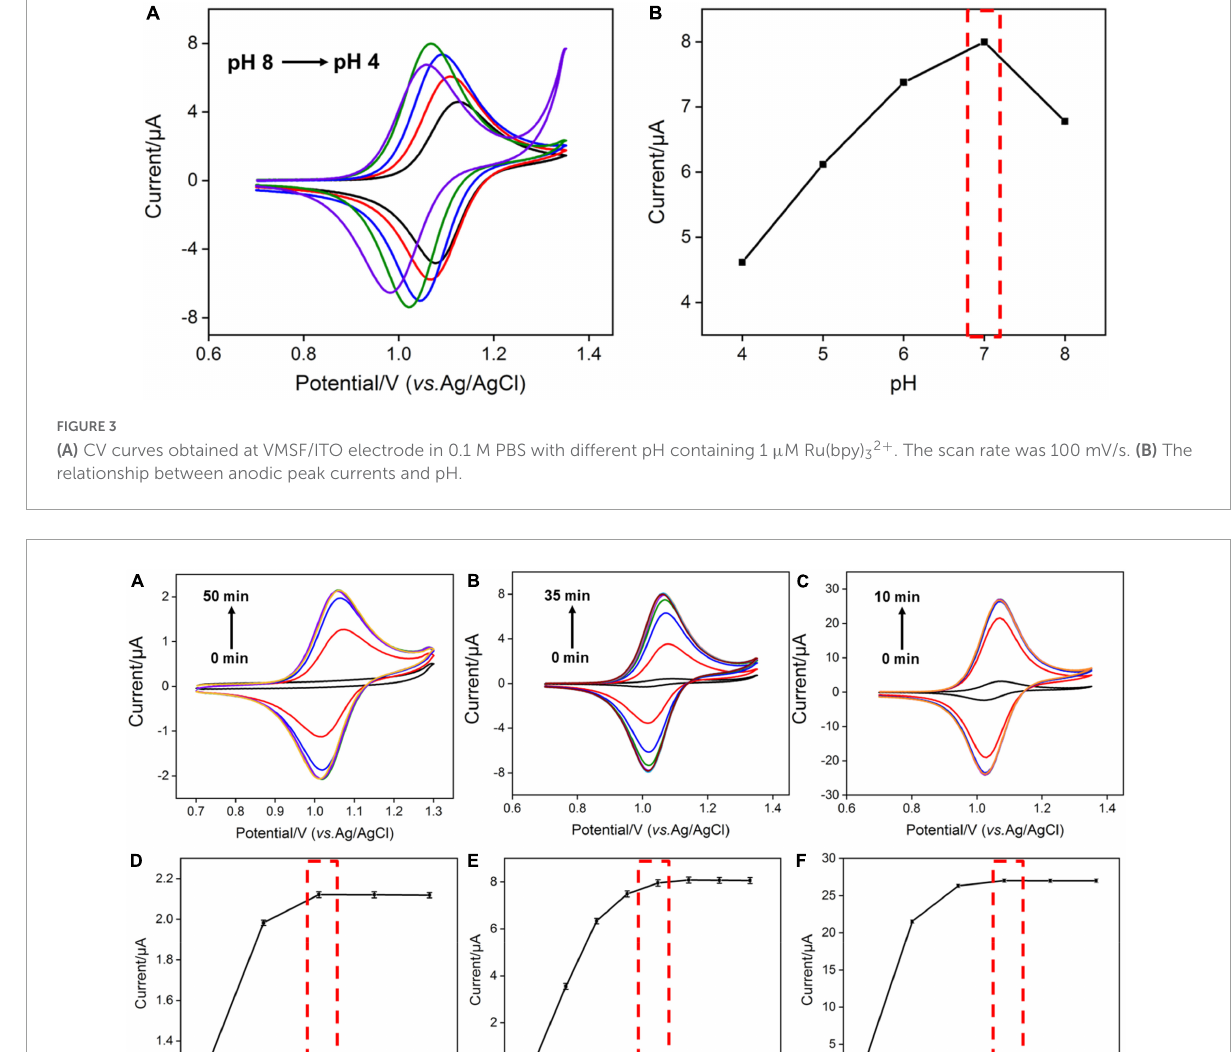
surface through the silica nanochannels and less amount of Ru(bpy) 32 + on the electrode